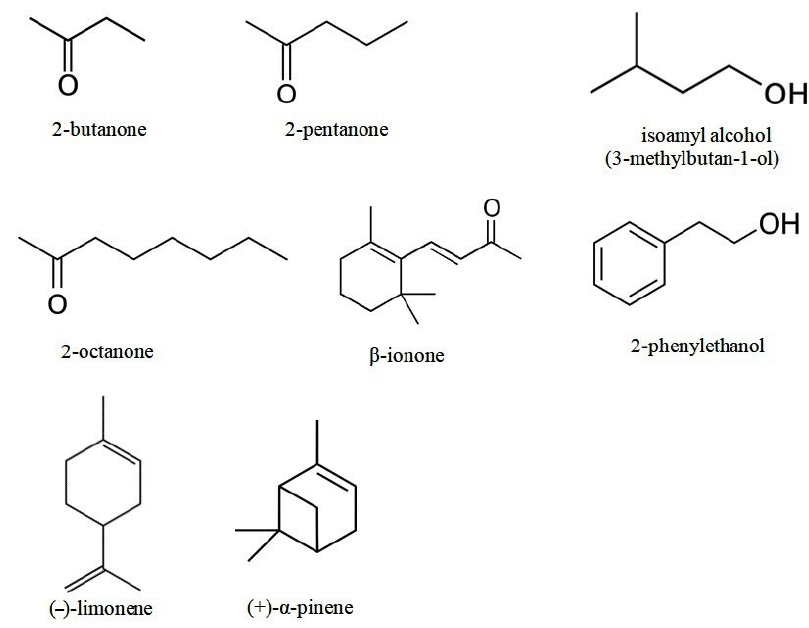
Figure 1. Volatile organic compounds used in this